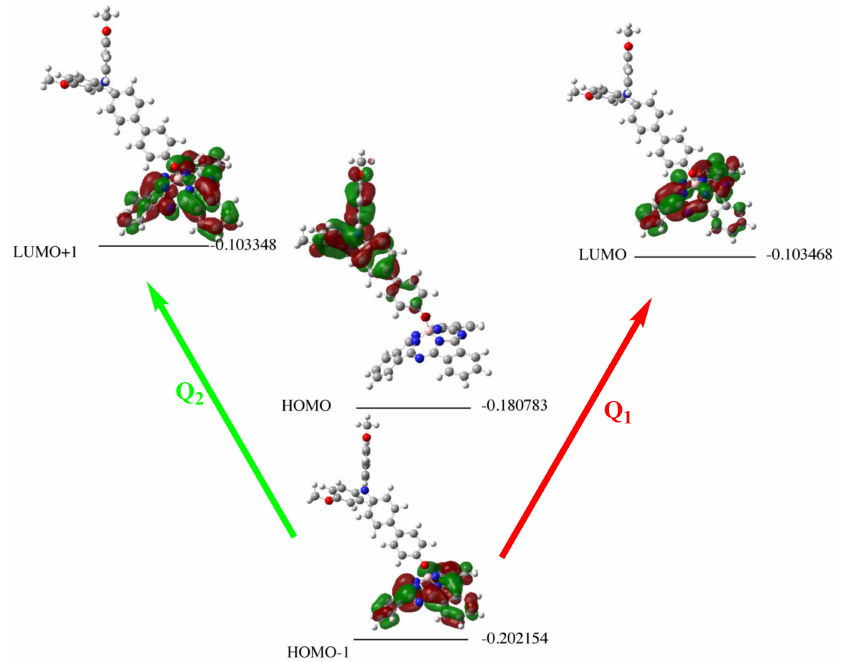
Figure 6. MO diagram of SubPc(A3,H,H,H), showing the main transitions Q 1 and Q 2 contributing to the Q band, which is not accompanied by a charge transfer phenomenon. Molecular orbital energies are in hartrees.